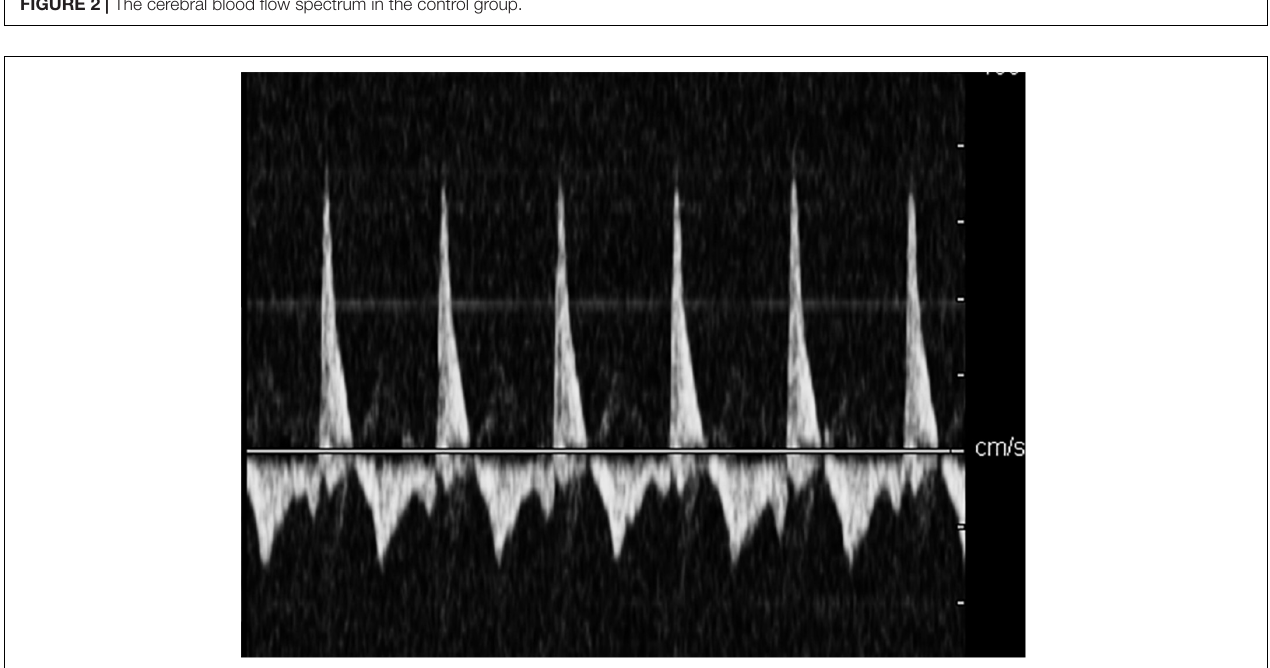
FIGURE 3 | The diastolic retrograde blood flow spectrum pattern when patient had clinical brain death.